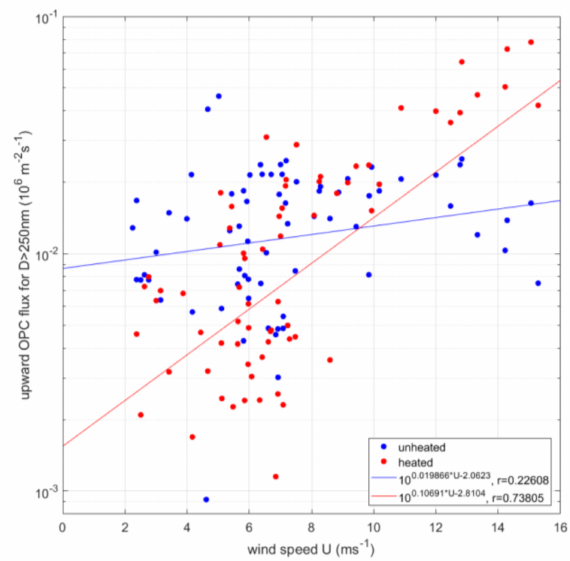
Figure 9. The total OPC aerosol number flux for all particles larger than 0.3 µ m diameter against the horizontal wind speed for the coastal sector. Blue circles are unheated dry aerosol fluxes. Red circles are the non-volatile aerosol fluxes. The corresponding straight lines are log-linear fits to the